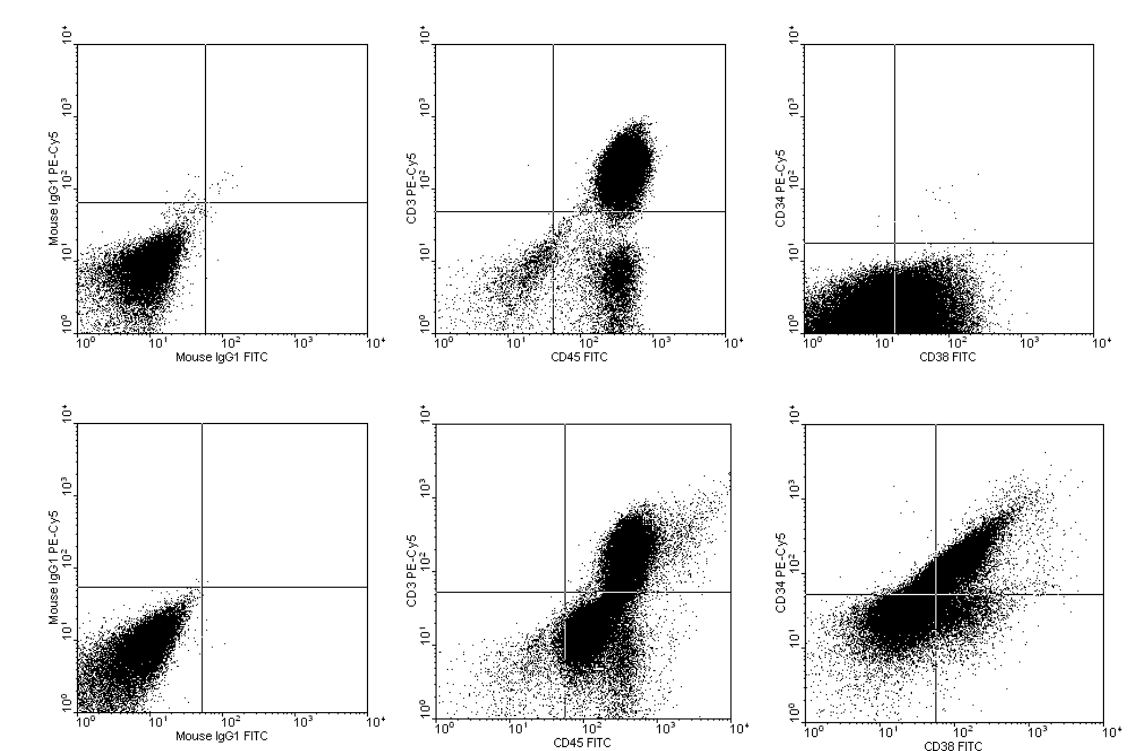
FIGURE 1. Representative immunophenotyping plots of apheresed mononuclear cells (Buffy coat) of patients with beta-thalassemia prior (A) and following (B) 3-h exposure to HCC. The panels on the left represent isotype controls (mouse IgG1-FITC and PE-Cy5 conjugates). The panels in the middle and right show costaining for CD45-FITC and CD3-PE-Cy5, and CD38-FITC and CD34-PE-Cy5,